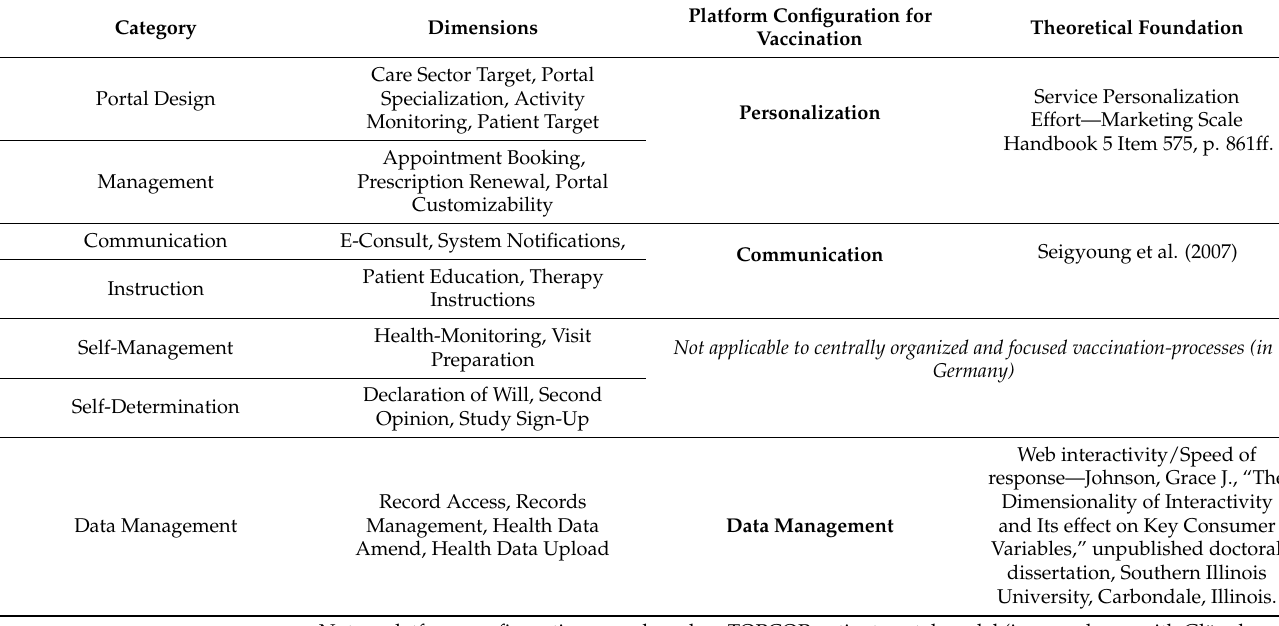
Table A2. Platform Configuration